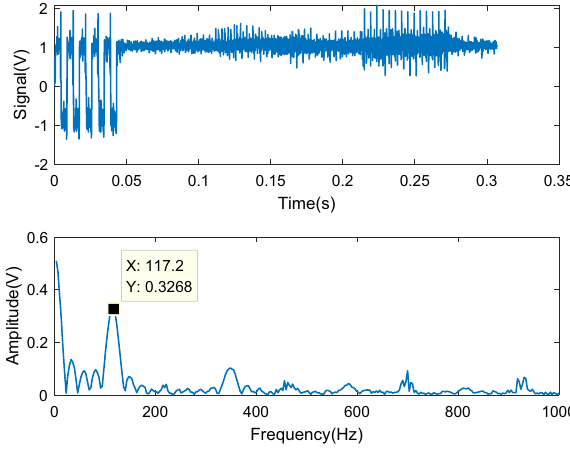
Fig. 8 Spectrum diagram of CS-SR and GWO-SR signal output